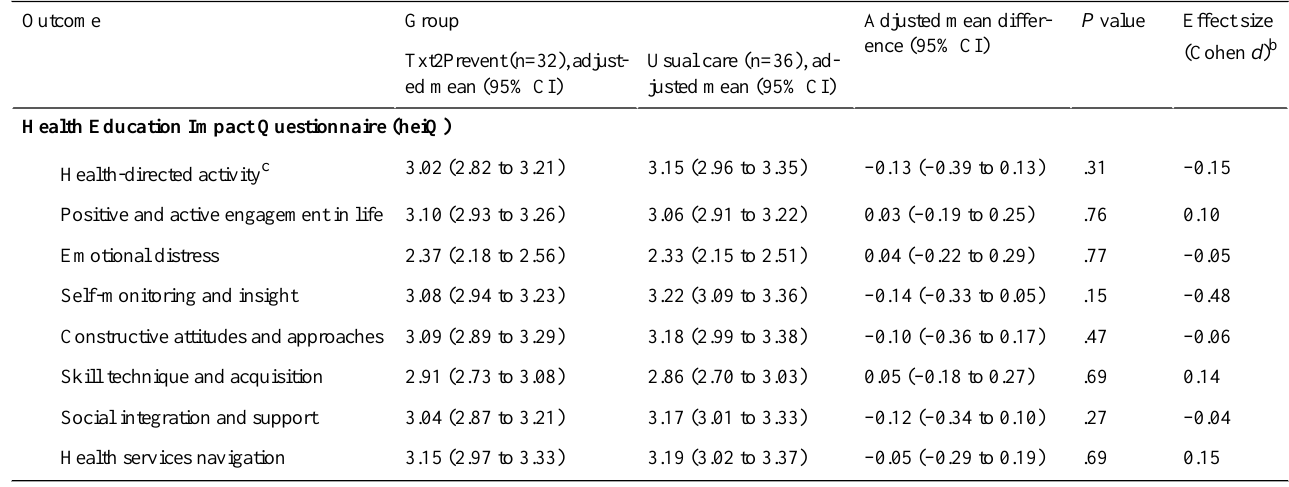
Table 4. Adjusted 60-day Health Education Impact Questionnaire (heiQ) scores, by group.